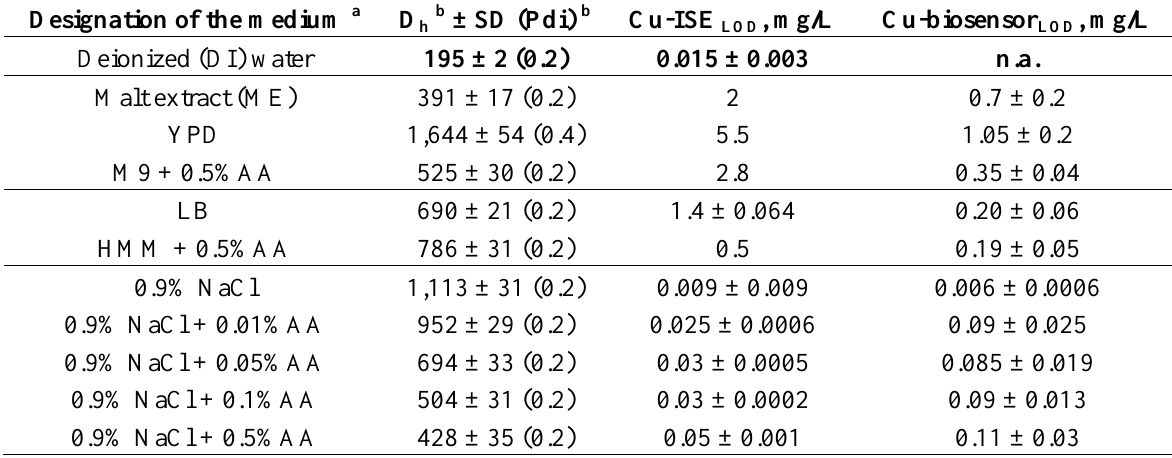
Table 3. Limit of detection (LOD) of Cu-ISE (indicative of free Cu ions) and Pseudomonas